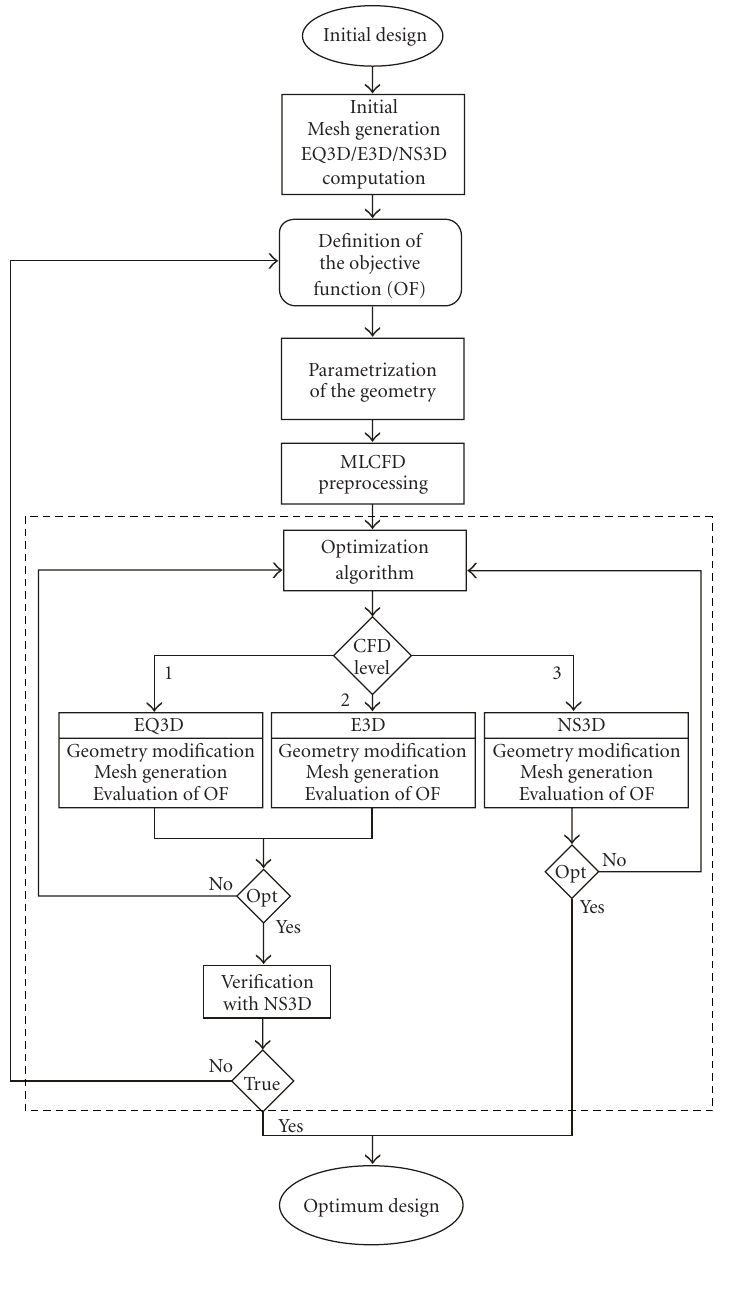
Figure 6: Optimization